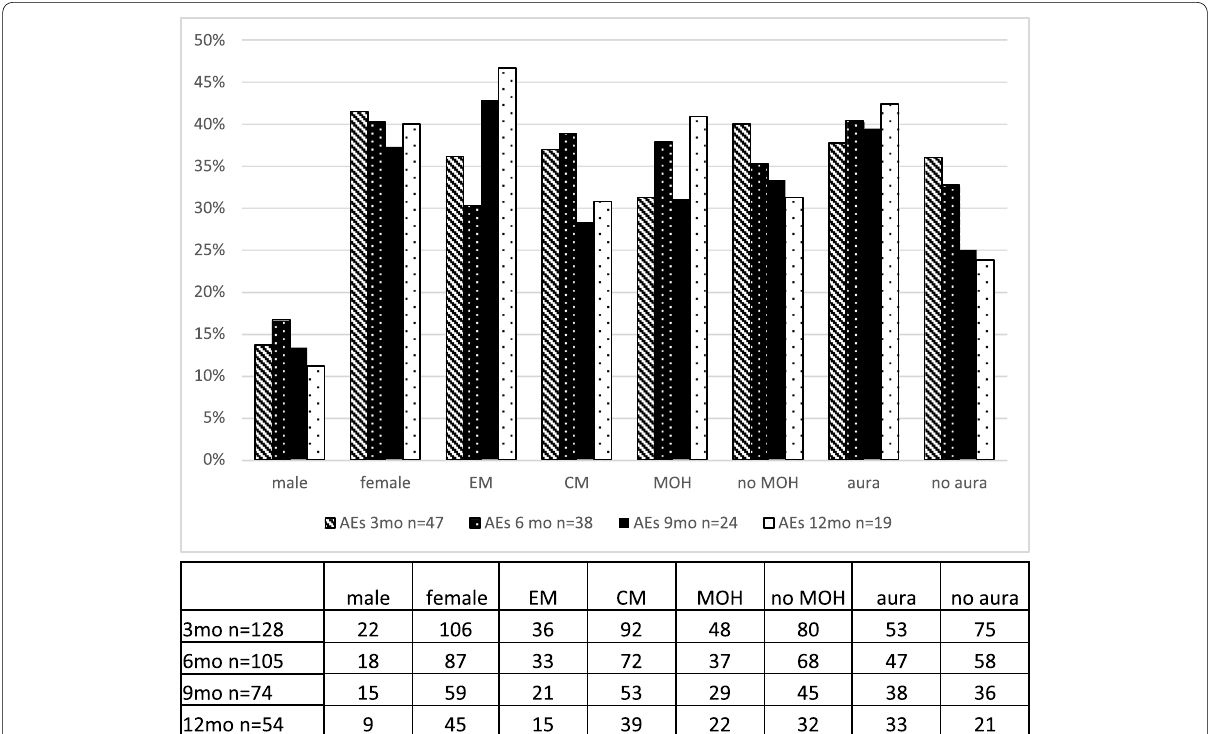
Fig. 1 Adverse events depending on patient characteristics. Patients’ characteristics like sex, medication-overuse headache and aura. Proportion of patients with the respective characteristics who reported